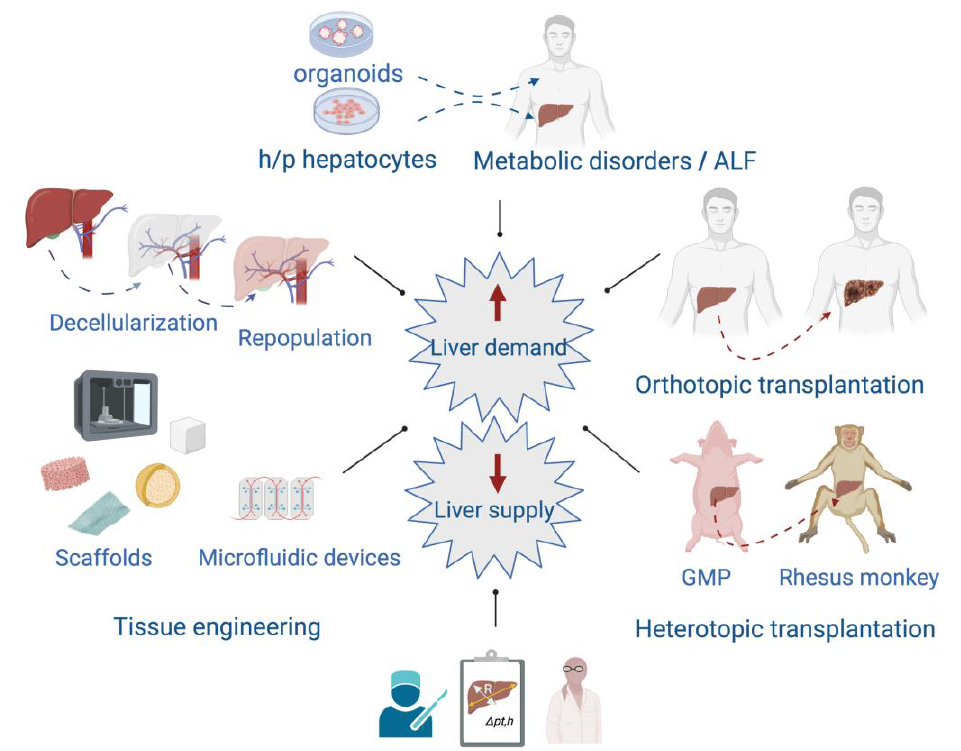
Figure 4. Interdisciplinary approaches focused on providing alternatives to patients affected by acute liver failure (ALF) and end-stage chronic liver diseases. In the left panel, some of the tissue- engineering techniques applied to provide scaffolds of different types are shown. At the top are included the transplantation of organoids or human/pig (h/p) hepatocytes to treat acute liver failure (ALF) and metabolic disorders. The right panel shows the orthotopic liver transplantation between individuals of the same species, and the heterotopic transplantation that involves donation from one species to another. Heterotopic transplantation can overcome the human organ shortage although there are several issues to solve such as hyperacute rejection and coagulation dysregulation. Nowadays, the use of genetically modified pigs (GMP) and immunosuppressive therapy are improving the recipients’ survival and increasing the possibility of eventual use in humans. At the bottom, the development of mathematical models as helpful tools in decision-making to perform liver surgeries.